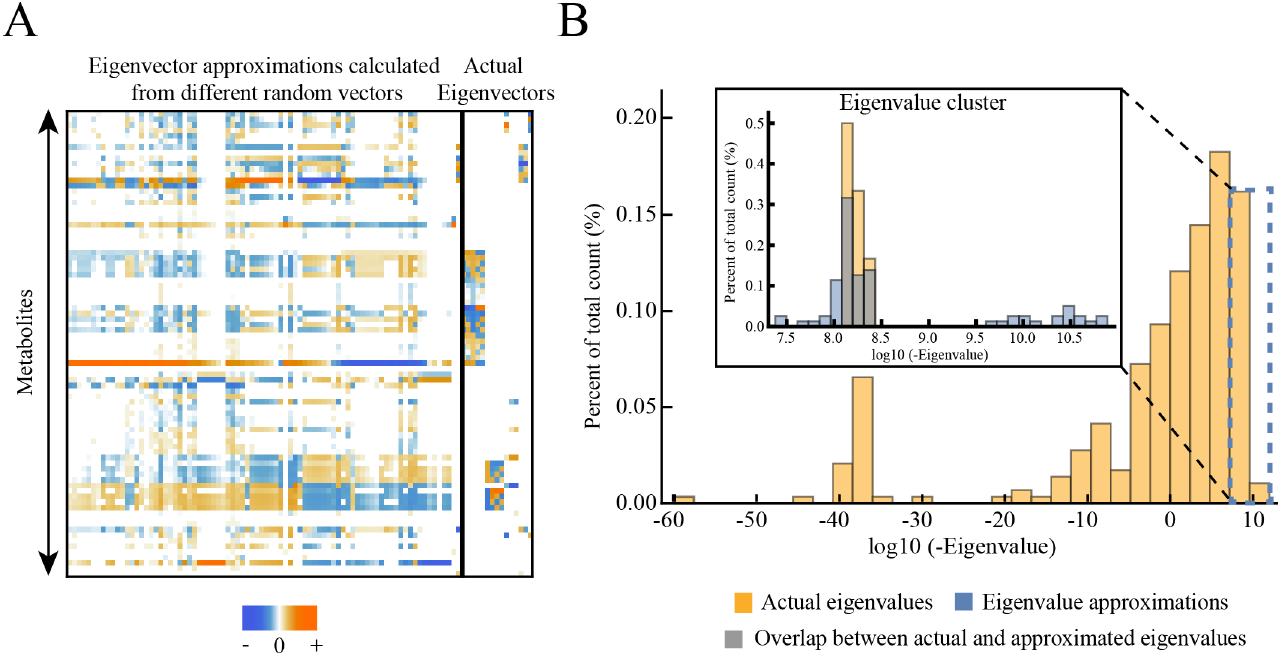
Fig 6. Eigenvalue and eigenvector approximations calculated from power iteration in cases where eigenvalues do not separate well. We selecteda cluster of close eigenvalues (with a time scale around0.016 milliseconds), reduced J using Hotelling’sdeflationmethod until this time scale was reached(see Materials and Methods), and calculatedapproximated eigenvaluesand eigenvectors using power iteration with different starting vectors. (A) Eigenvector approximations calculatedduringpower iteration from different starting vectors, comparedto the actual eigenvectors with eigenvaluesin the selectedrange. We calculatedthe approximated 100 eigenvectors from 100 different random vectors with 100 iterationseach and obtainedvectors that are linearlyindependentwith each other (see Materials and Methods). The left part of the matrix shown is the eigenvector approximations whilethe right part of the matrix shown is the actual eigenvectors, separately by the black bold vertical line. We found that the subspaceformed by eigenvector approximations overlaps significantly with the actual eigenvector subspace.(B) The selectedeigenvaluecluster is comparedto the eigenvalue approximations calculatedfrom power iteration. The selectedeigenvalues and eigenvalue approximations are shown in the inset plot. We obtained the eigenvalueapproximations from the same set of power iterations performed in panel A. The cluster of eigenvalue approximations overlaps significantly with the cluster of actual eigenvalues, showingthat the eigenvalue approximations settle in the range of the set of similarlydominant